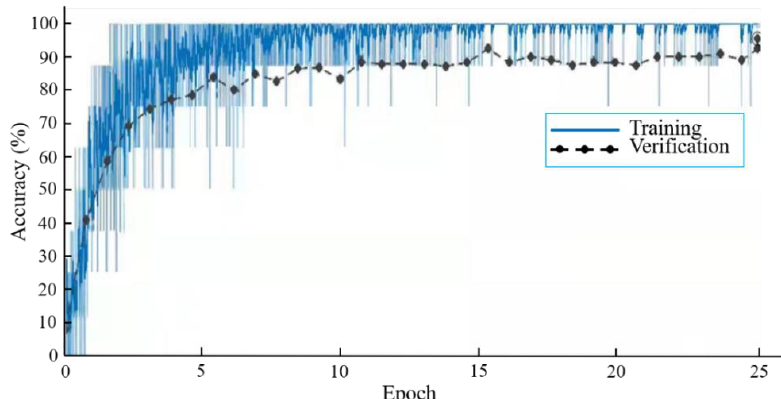
Figure 4. Accuracy curves.